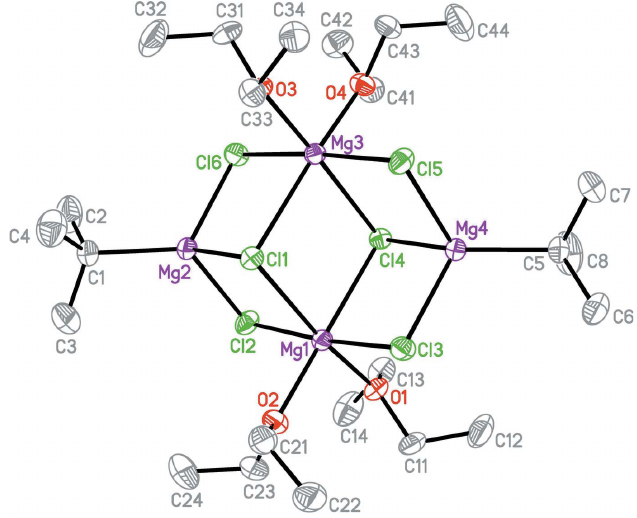
Figure 3 Molecular structure of the title compound. Displacement ellipsoids are drawn at the 50% probability level. Hydrogen atoms are omitted for